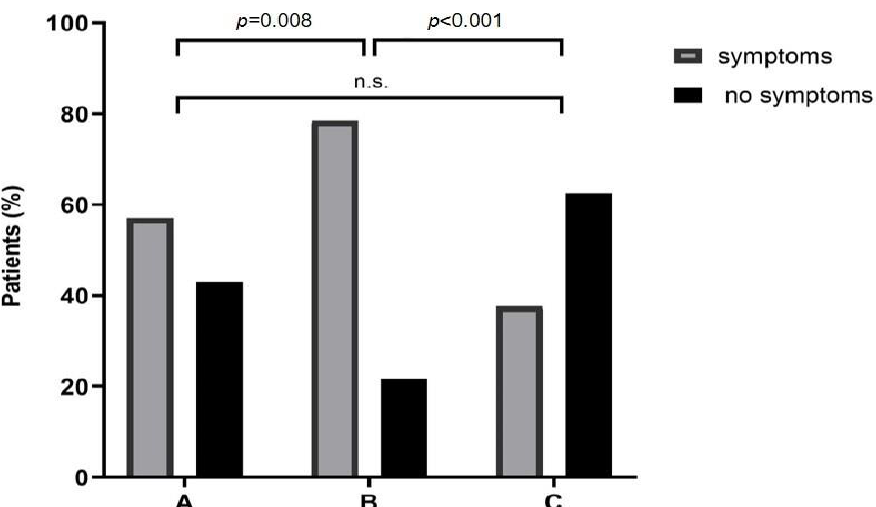
Figure 3. A total of 164 of 279 LIT patients indicated symptoms during lactose H 2 breath tests. In group A (increasing expiratory H 2 values from baseline >20 ppm) 28 patients of 49 (57%), in group B (increase >20 ppm of expiratory H 2 from baseline and BG increase of <20 mg/dL) 95 patients of 121 (79%), and in group C (BG increase <20 mg/dL) 41 patients of 109 (38%) patients designated symptoms. BG, blood glucose; H 2 , hydrogen; LIT, lactose intolerance; ppm, parts per million; n.s., not significant.